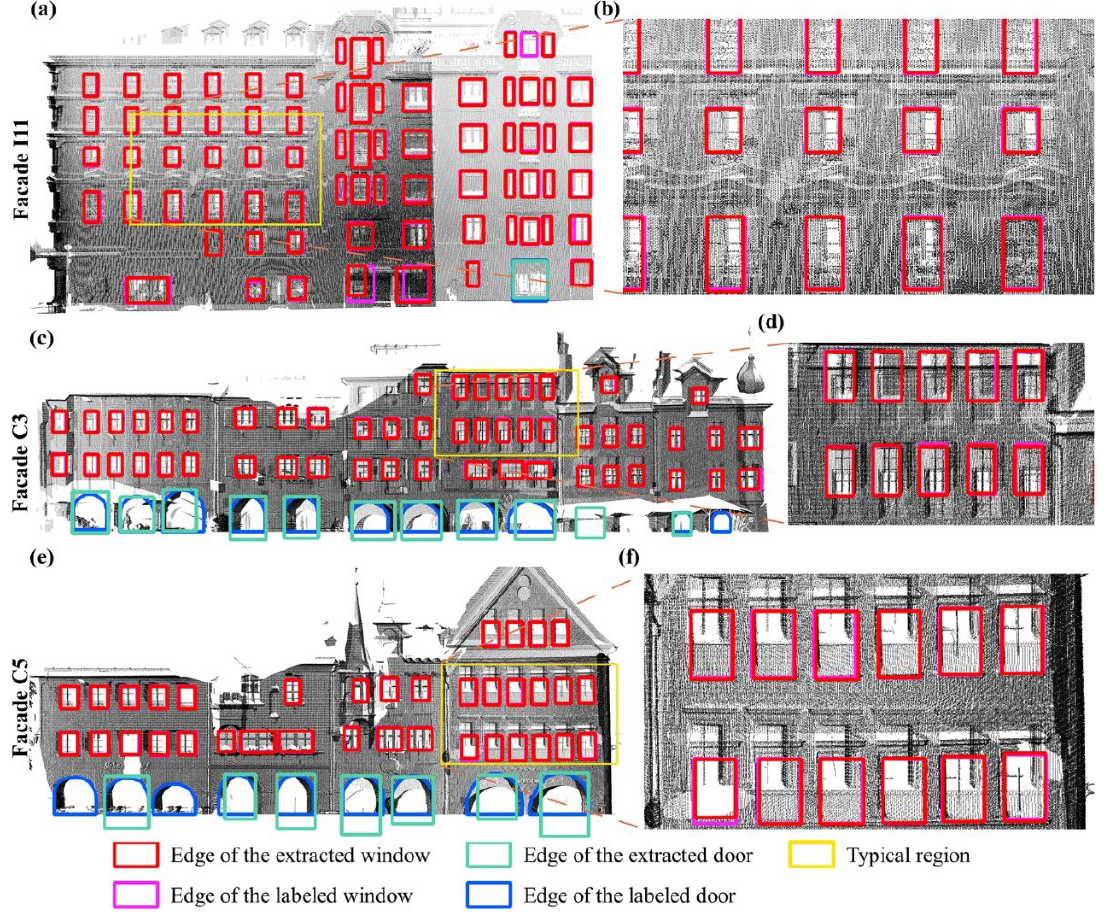
Figure 19. Details of facade map extraction: ( a , c , e ) results of the facade map extraction for facades I11, C3, and C5, respectively; and ( b , d , f ) results of zooming in on the misaligned area.